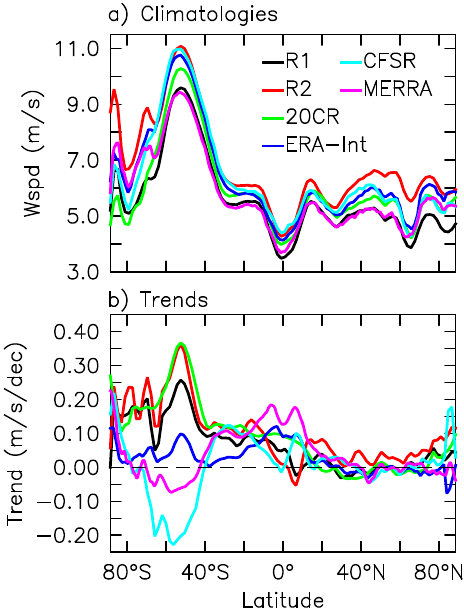
Figure 7. (a) Zonal mean 10m wind speed climatologies over 1980 to 2010 in six reanalyses and (b) zonal mean wind speed trends over the same period. Wind speeds are compared, rather than surface stress fields, because the latter are sensitive to the choice of drag